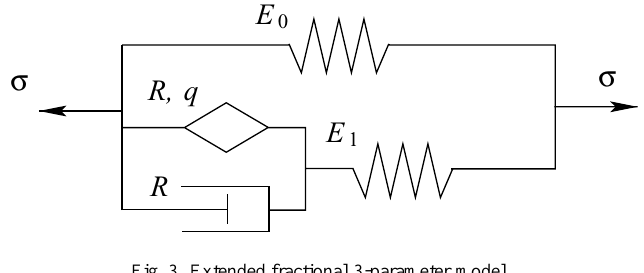
Fig. 3. Extended fractional 3-parameter